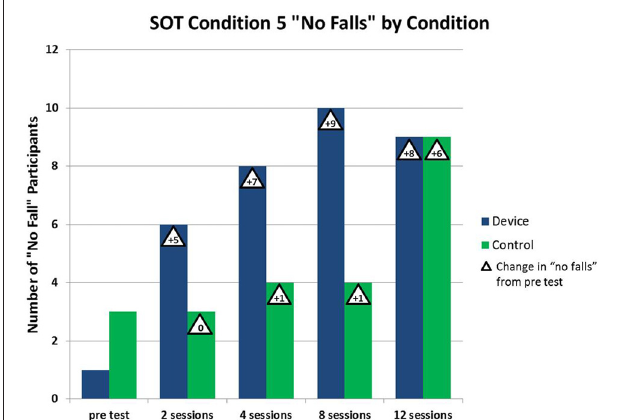
FIGURE 5 | Beneficial effect of vestibular rehabilitation. As the number of vestibular rehabilitation sessions increases, the number of patients who do not fall during SOT #5 increases. The beneficial effect is more pronounced with the device group using the tactile cue (Atkins and Gottshall,